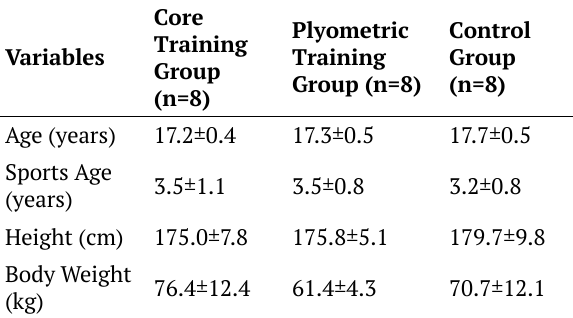
Table 3. Characteristics of the